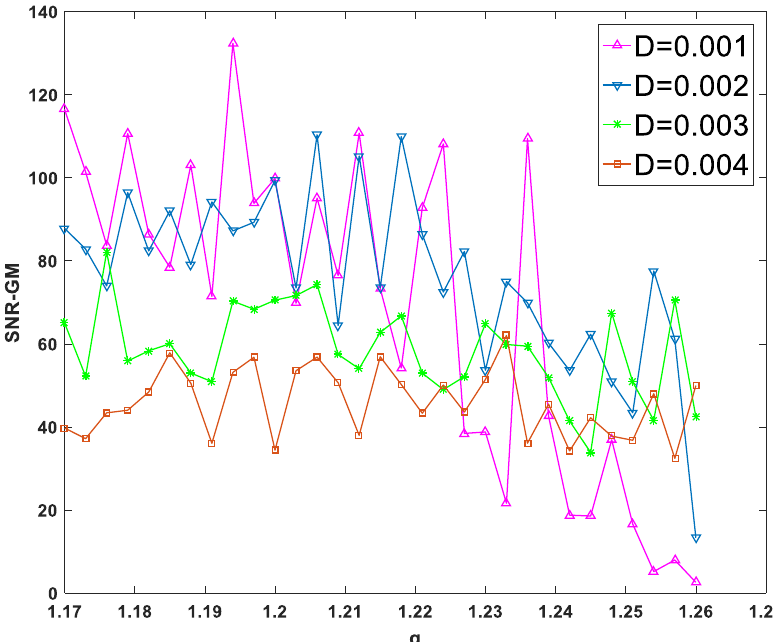
Figure 7. SNR-GM varies with m for different values of D ( m = 2.0, p = 0.5).